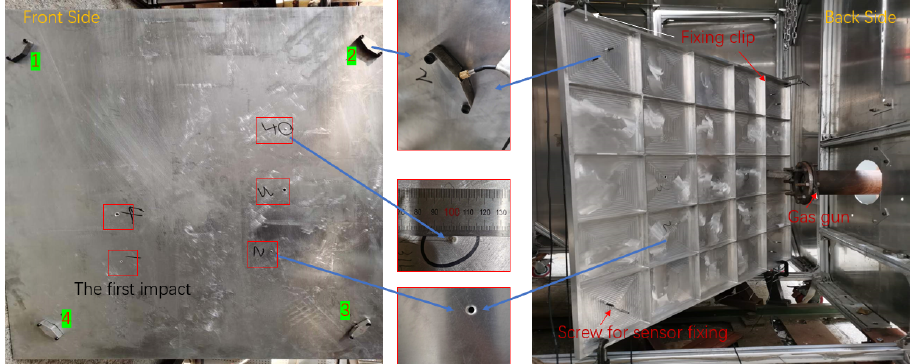
Figure 10. Experimental setup for the impact test of a plate